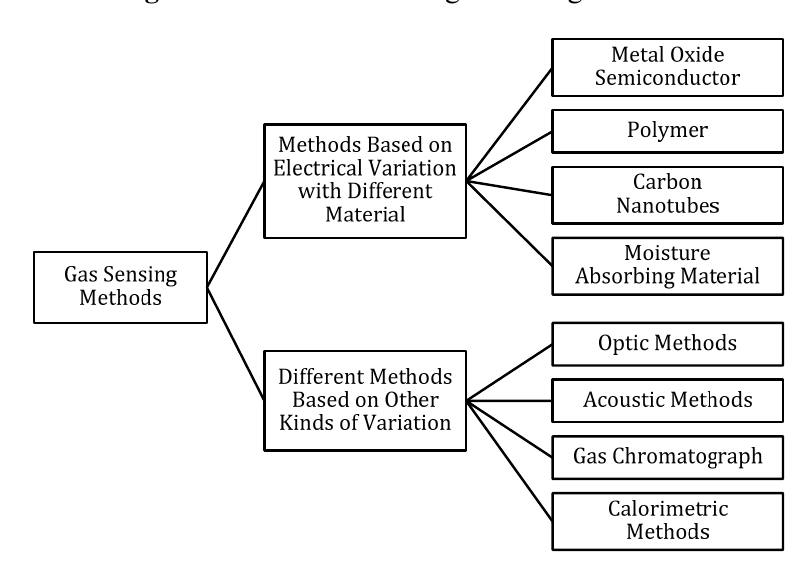
Figure 1. Classification of gas sensing